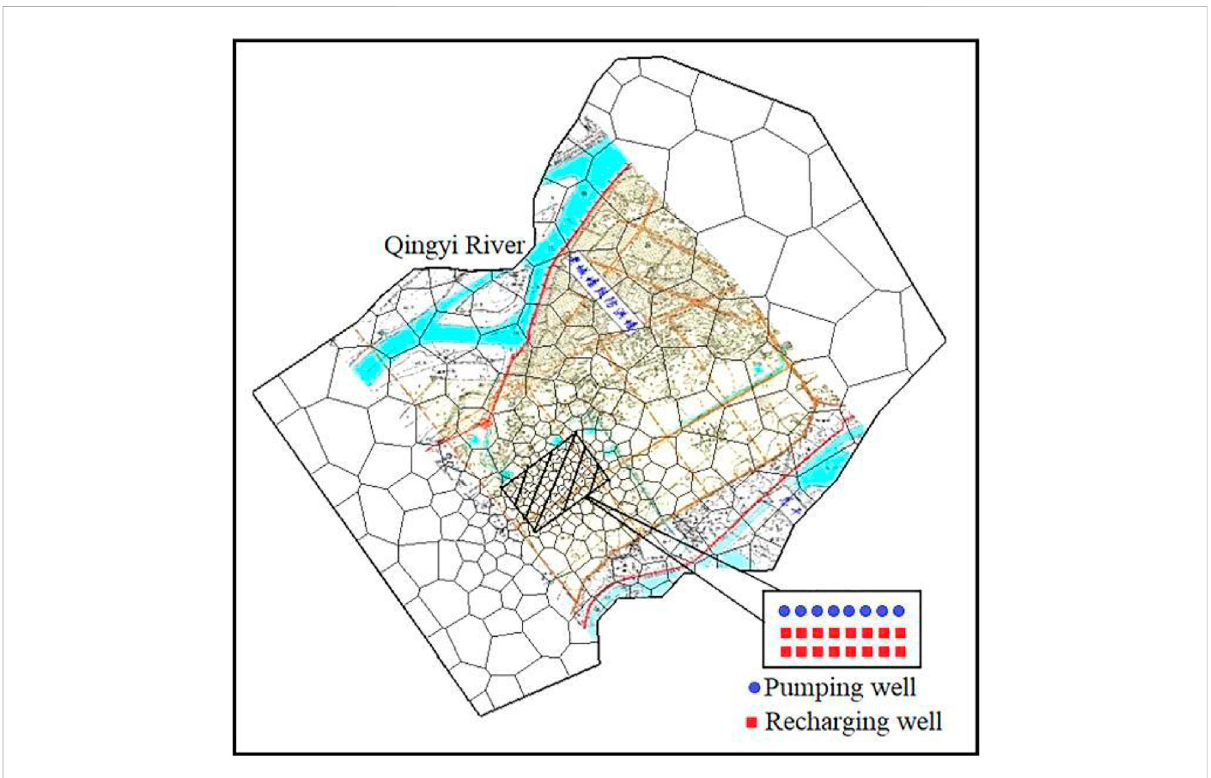
FIGURE 3 Model subdivision